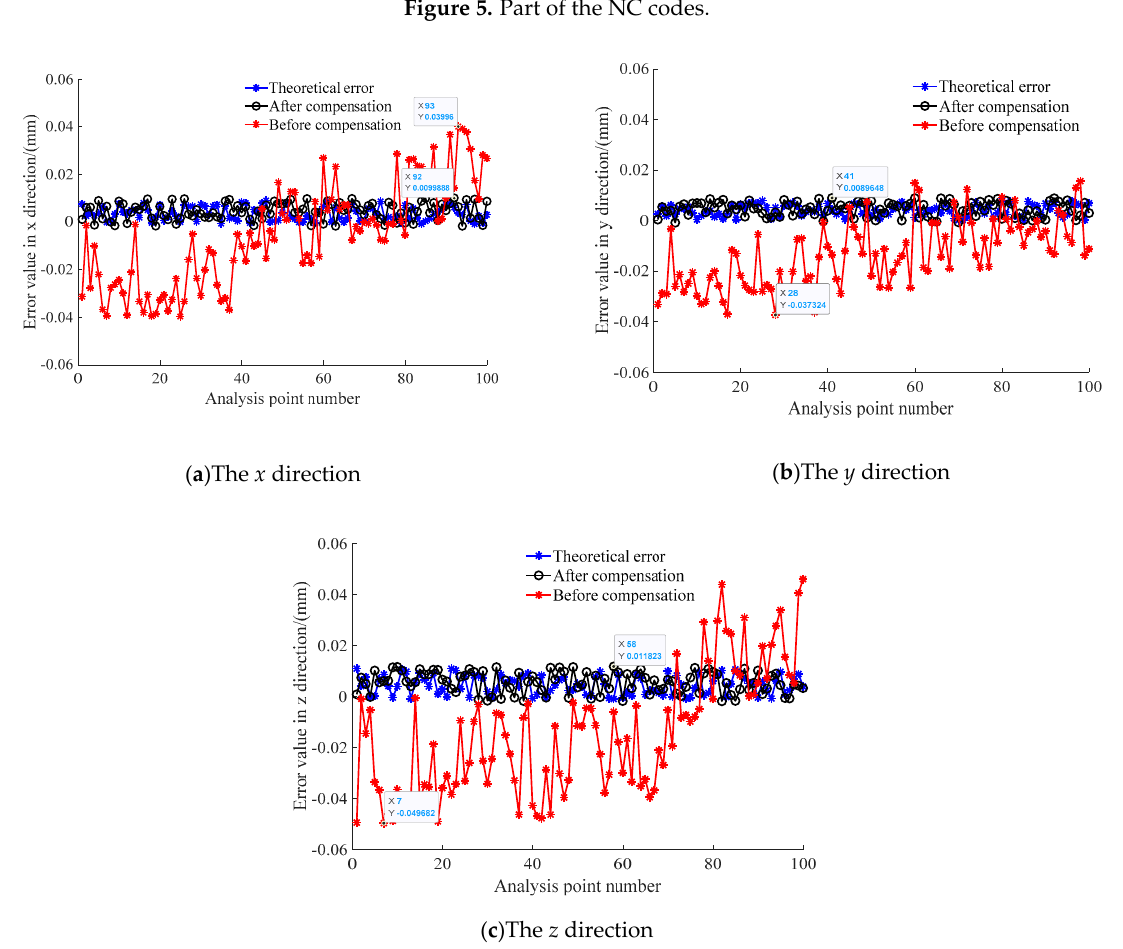
Figure 6. Comparison of results before and after compensation in each direction.